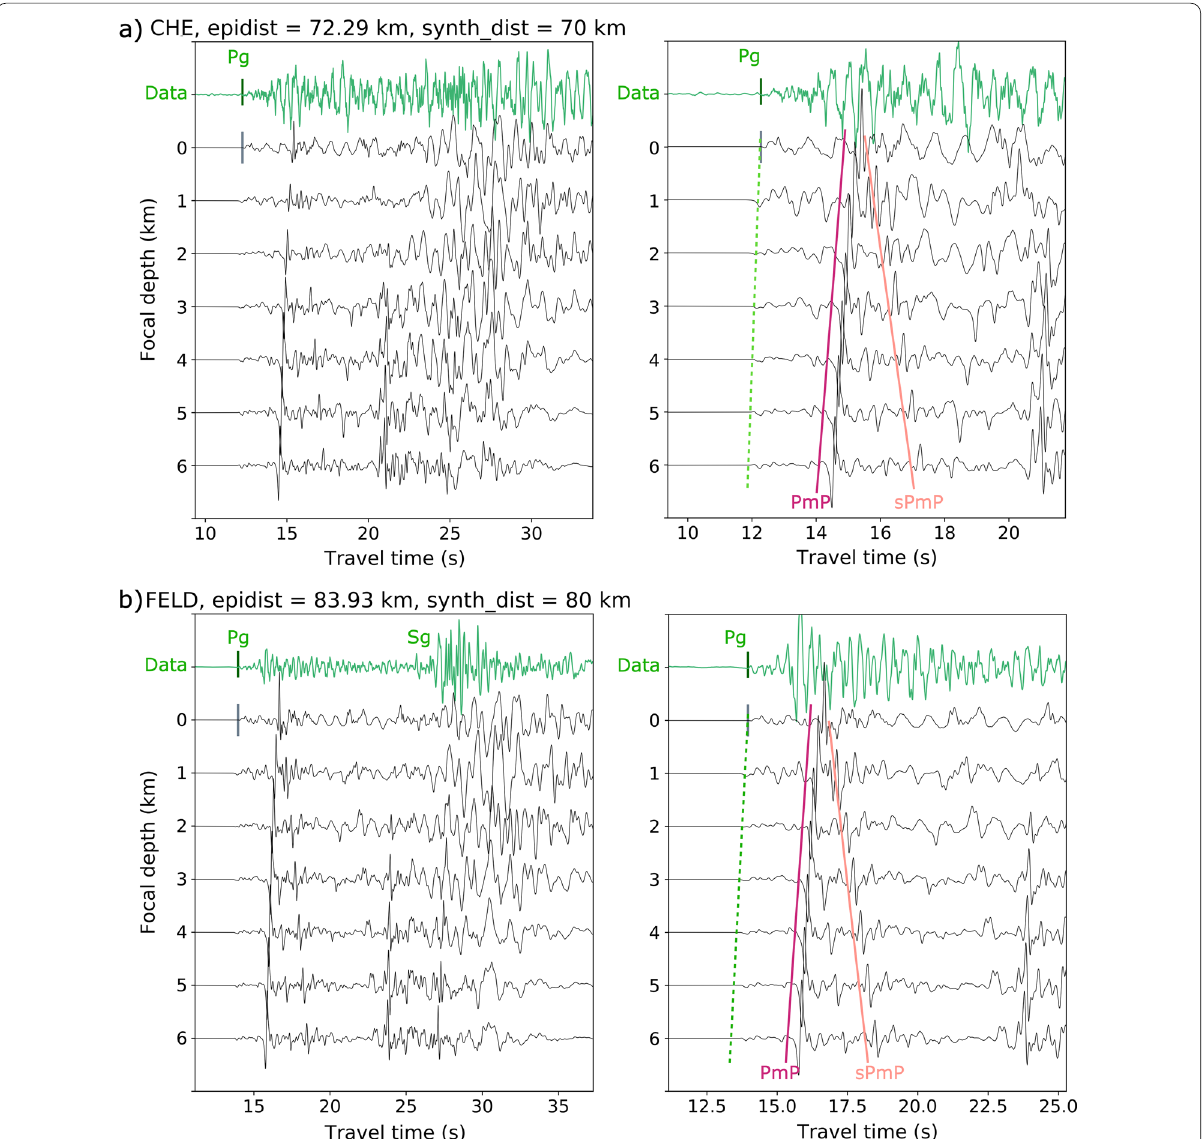
Fig. 7 Synthetic waveform modelling at stations CHE (distance ~ 70 km) and FELD (distance ~ 80 km). The right panel shows a zoom-in view around the P arrival time of the panel on the left. In each panel the top trace (green)represents the vertical component of the M L 3.2 event of 2000 recorded at both CHE and FELD, respectively, whereas the bottom traces are synthetic seismograms for focal depths 0–6 km. Note how the sPmP is not visible in the data, matching the synthetic seismograms for depth shallower than 1